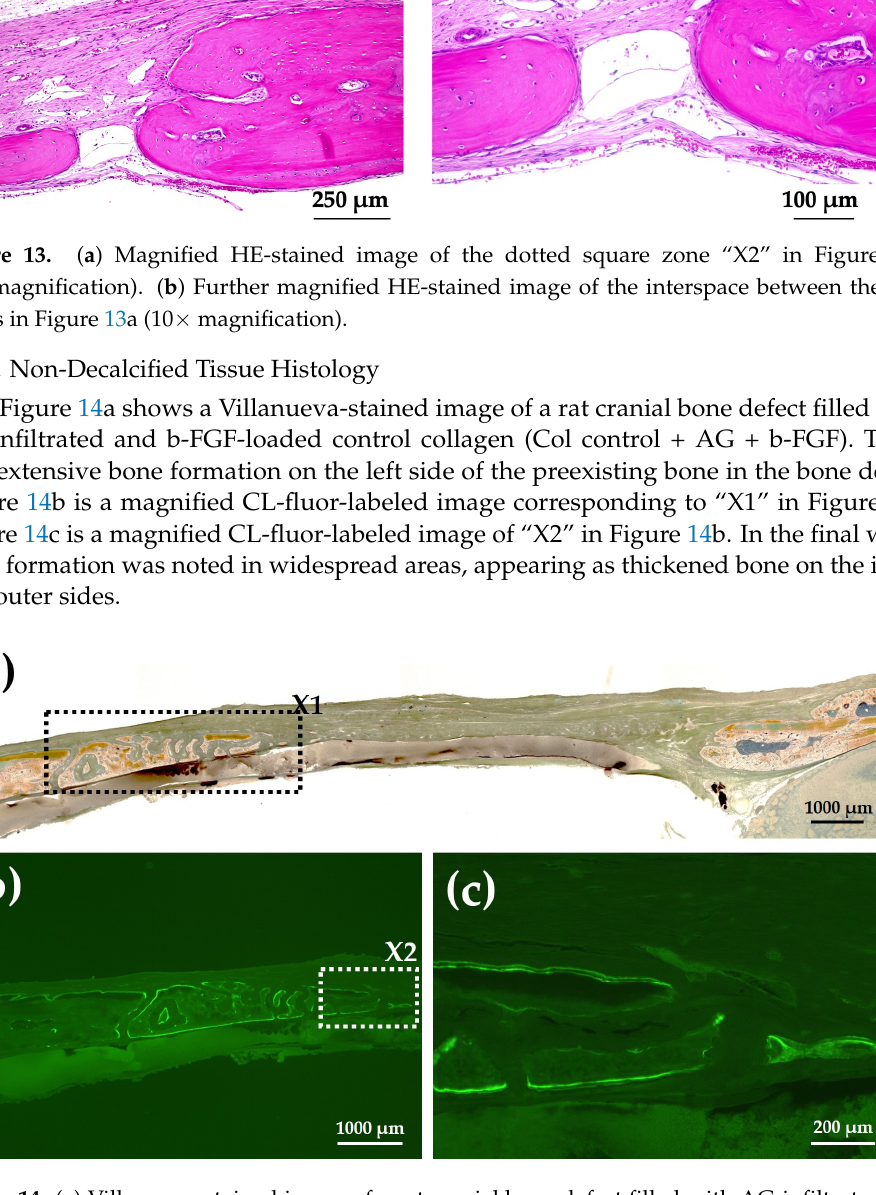
Figure 14. ( a ) Villanueva-stained image of a rat cranial bone defect filled with AG-infiltrated and b-FGF-loaded control collagen (Col control + AG + b-FGF) (4× magnification). ( b ) Magnified CL-fluor-labeled image corresponding to “X1” in Figure 14a (4× magnification). ( c ) Further magnified CL-fluor-labeled image corresponding to “X2” in Figure 14b (10× magnification).